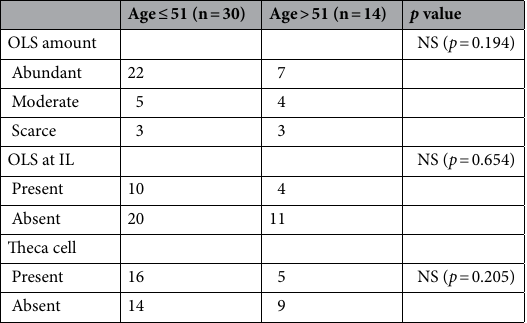
Table 3. The relationship between OLS data and patients’ age in female pancreatic MCN. IL, inside the pancreatic lobule; MCN, mucinous cystic neoplasm; OLS, ovarian-like